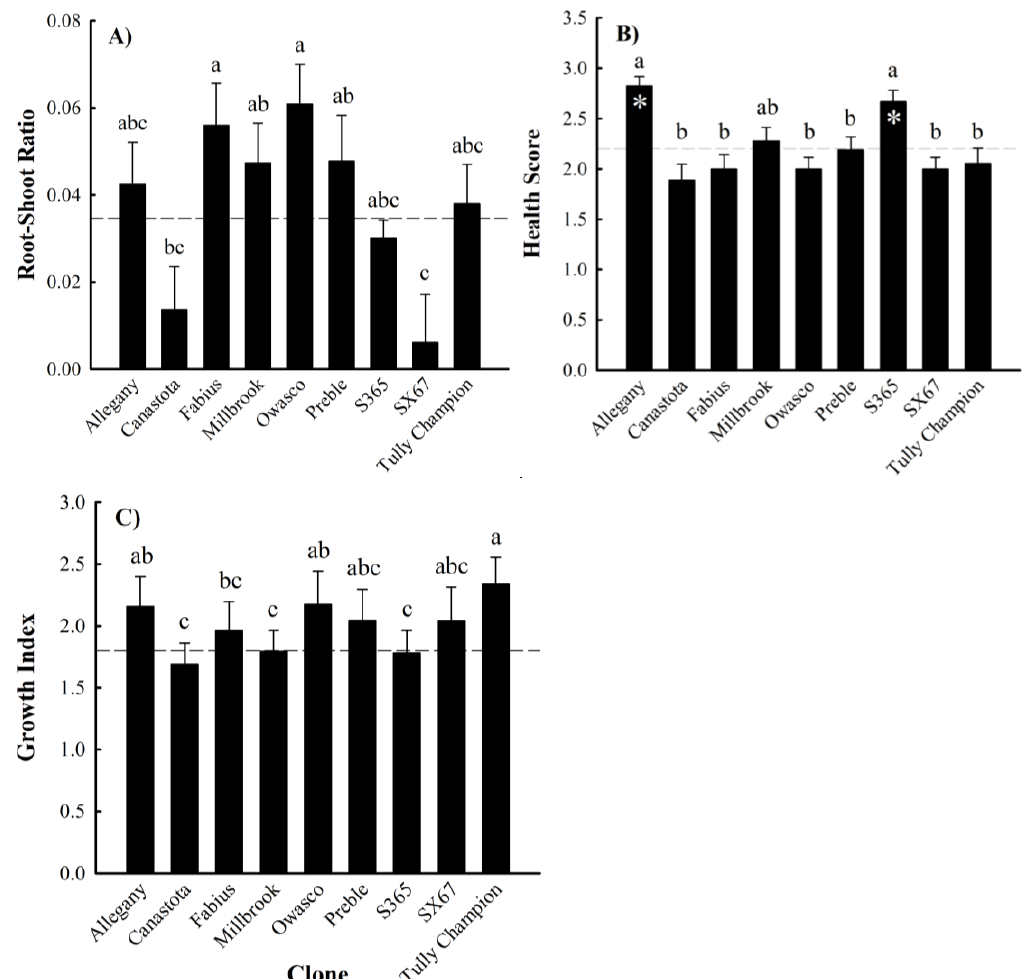
Figure 3. Root–shoot ratio ( A ), health score ( B ), and growth index ( C ) for the Salix clone main effect in a study assessing the relationships among root–shoot allocations, early growth, and health of hybrid poplar and willow clones when grown for 65 days in soils from five landfills in eastern Wisconsin, USA. The dashed line represents the overall mean, while bars with asterisks indicate means that differ from the overall mean at p < 0.05. Bars with the same letters were not different according to Tukey’s adjustment at p > 0.05.